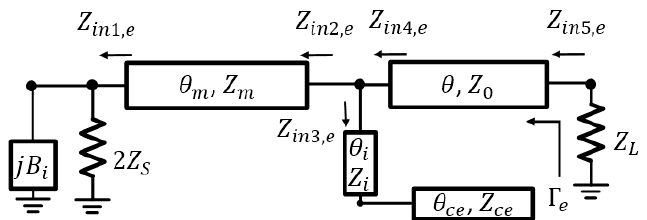
Figure 2. Bisected network with open-circuit bisecting plane at the plane of symmetry for even-mode analysis.